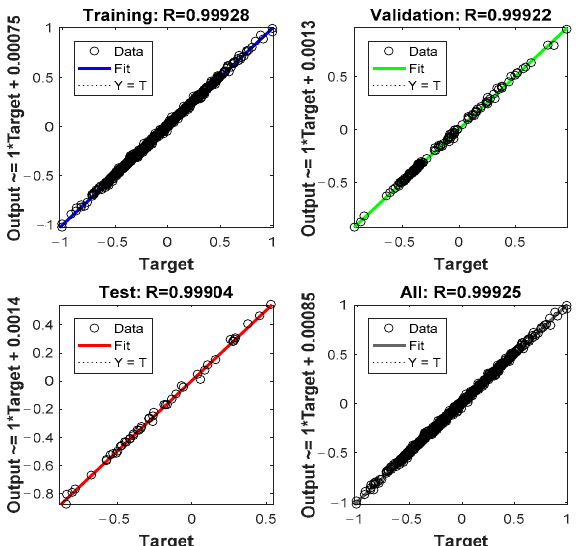
Figure 13. Regression results of FFNN after training.